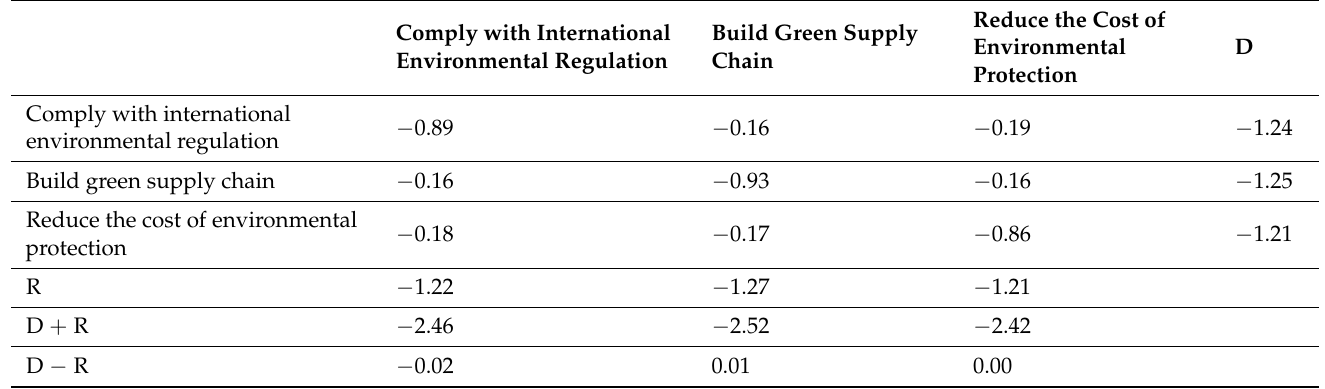
Table 4. Impact degree of environmental